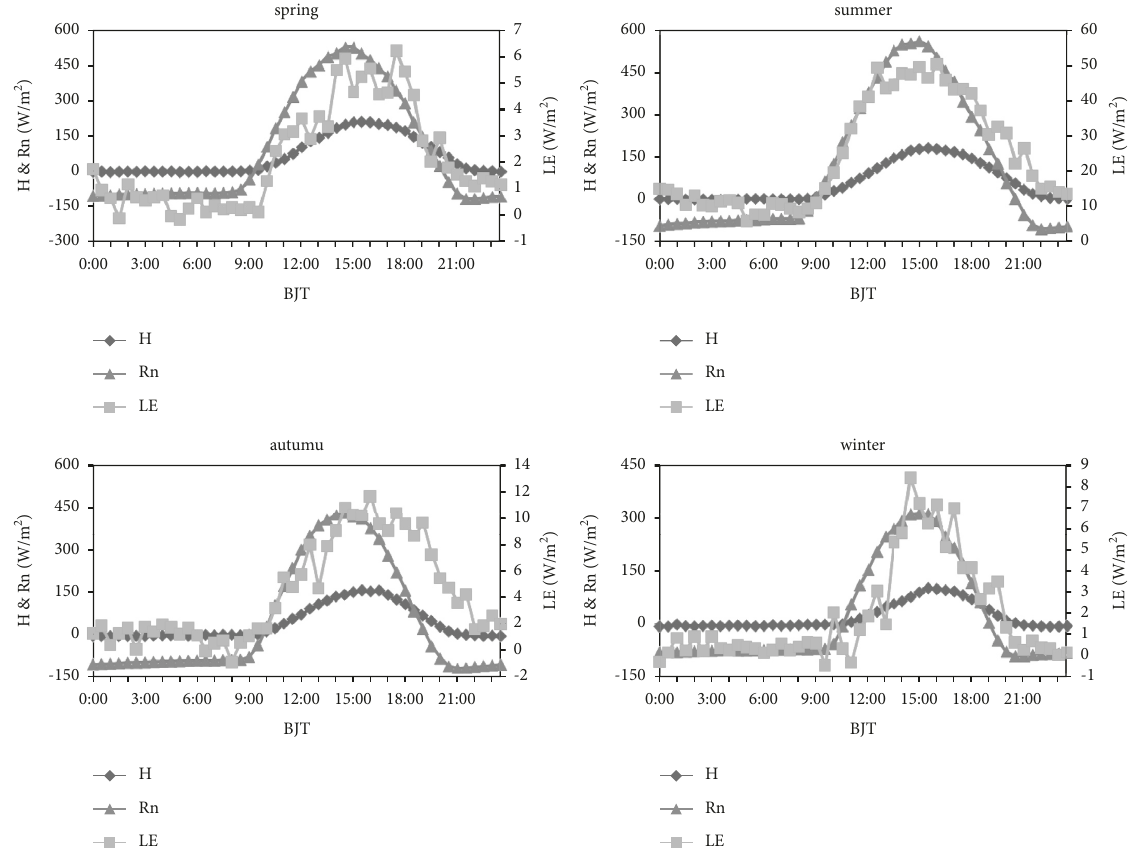
Figure 1: The intraday variation characteristics of the sensible heat, latent heat, and net radiation